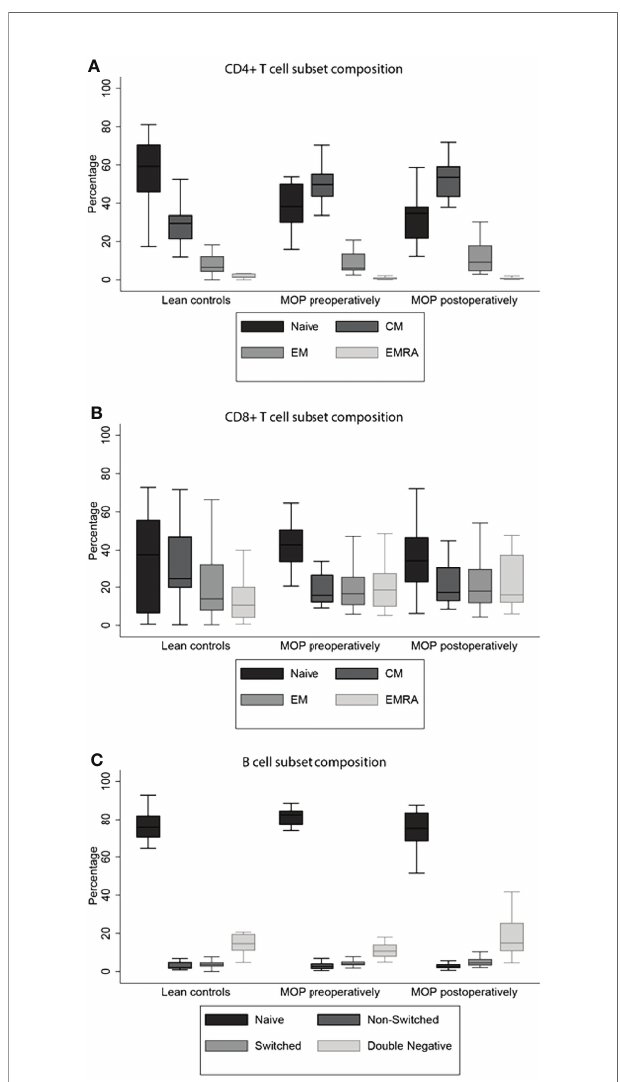
FIGURE 1 | T and B cell subset compositions. Morbid obesity causes a signi fi cant decrease in percentage of naive CD4+ T cell (A) . The CD8+ T EMRA cells were signi fi cantly higher in morbidly obese patients, both preoperatively and postoperatively (B) . Both percentages of non-switched and switched B cells were increased in morbidly obese patients (C) . Percentages and signi fi cances are depicted in Supplementary Table 3A . MOP, morbidly obese patients; CM, central memory; EM, effector memory; EMRA, terminally differentiated effector